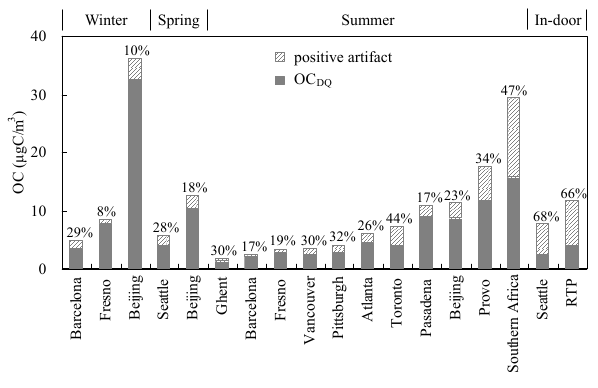
Fig. 7. Comparison of positive artifact of Beijing carbonaceous aerosol with other regions. Results from low-volume in-door sampling are also shown. Positive artifact was calculated as the difference between OC measured by bare (OC BQ ) and denuded (OC DQ ) quartz filter. The percentage is the fraction of positive artifact in OC BQ . Data from Viana et al., 2006b (Barcelona, Spain), Chow et al., 2006 (Fresno, CA), Lewtas et al., 2001 (Seattle, WA), Viana et al., 2006a (Ghent, Belgium), Fan et al., 2004 (Vancouver, Canada), Cabada et al., 2004 (Pittsburgh, PA), Solomon et al., 2003 (Atlanta, GA), Fan et al., 2003 (Toronto, Canada), Mader et al., 2001 (Pasadena, CA), Ding et al., 2002 (Provo, UT), Eatough et al., 2003 (southern Africa), Pang et al., 2002 (Seattle, WA; in-door) and Olson and Norris, 2005 (Research Triangle Park (RTP), NC; in-door).